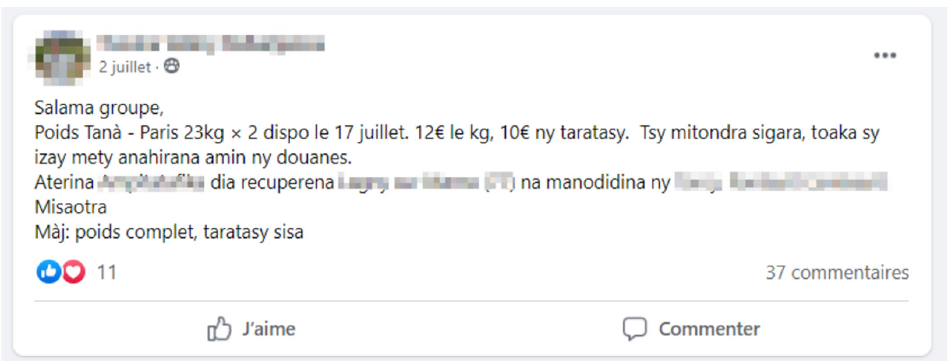
Figure 2. Capture of an offer of freight from the GSF